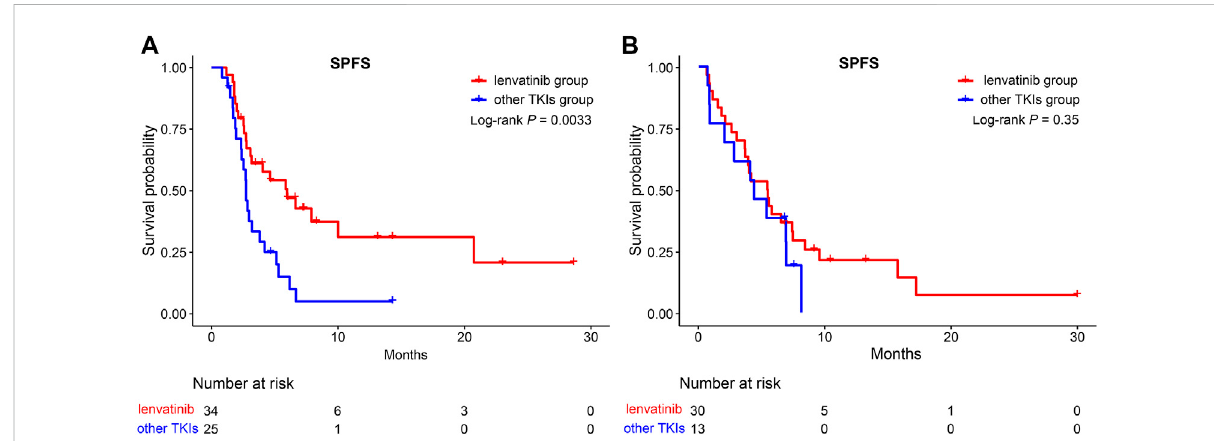
FIGURE 7 Kaplan-Meiercurvesfor SPFS ofpatients inthe lenvatinib group and theotherTKIs group. (A) A subgroupof patients after lenvatinibas fi rst-line